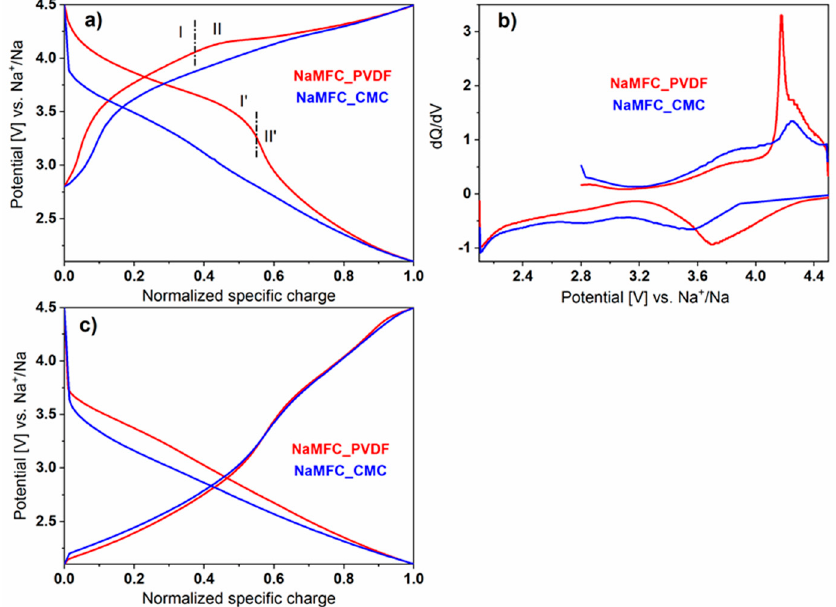
Figure 5. ( a ) Galvanostatic curves of NaMFC electrodes cycled at C/10 at the 1 st cycle; ( b ) Derivative curve dQ/dV of the galvanostatic curve of NaMFC electrodes cycled at C/10 at the 1 st cycle where the absence of the intense peak at 4.2 V vs. Na + /Na for the NaMFC_CMC electrode during the charge is obvious; ( c ) Galvanostatic curves of NaMFC electrodes at the 50th cycle when the cells are cycled at C/10 rate.